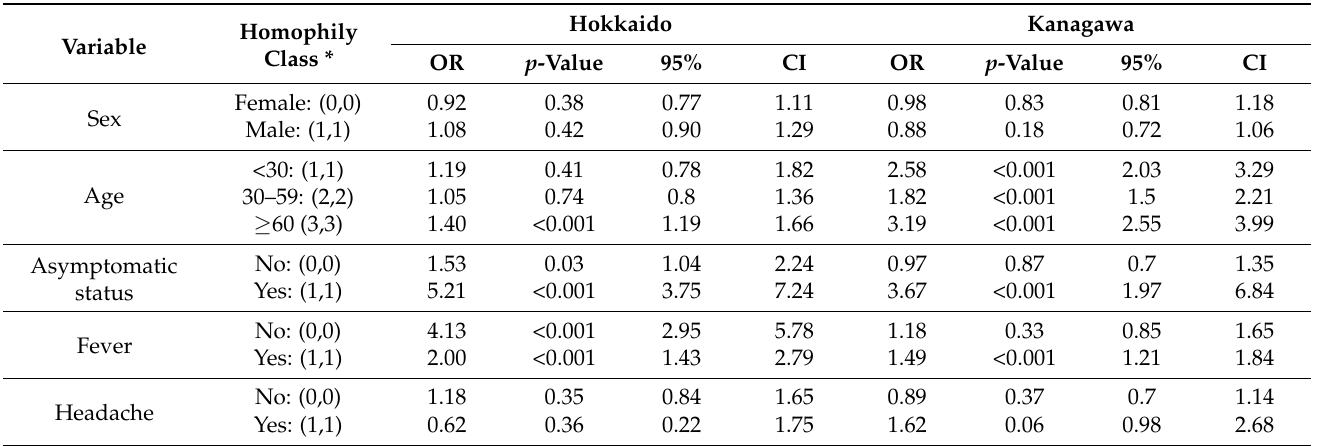
Figure 6. Setting of Viral Transmission in Viral Transmission Networks. The settings in which COVID-19 cases originated are shown. Most frequently, the cases originated in a medical facility (green). Family settings (purple) were also important origination settings for the disease, as were work settings (blue), although to a lesser extent. Circle sizes denote the impact (number of infectees). Table 7. Sex, Age, and Symptom Homophilies in Viral Transmission Networks by